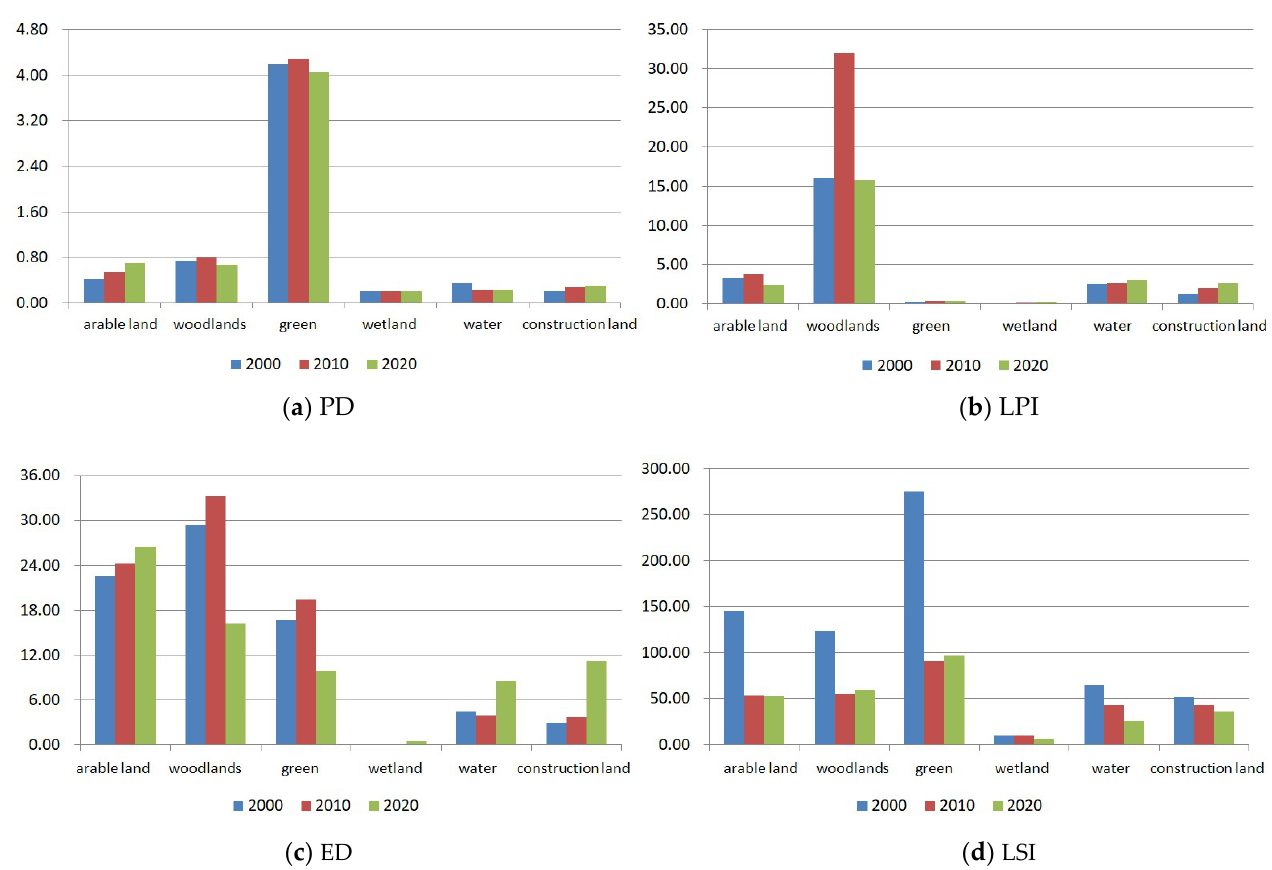
Figure 2. Evolution of landscape index at the patch level in urban areas.